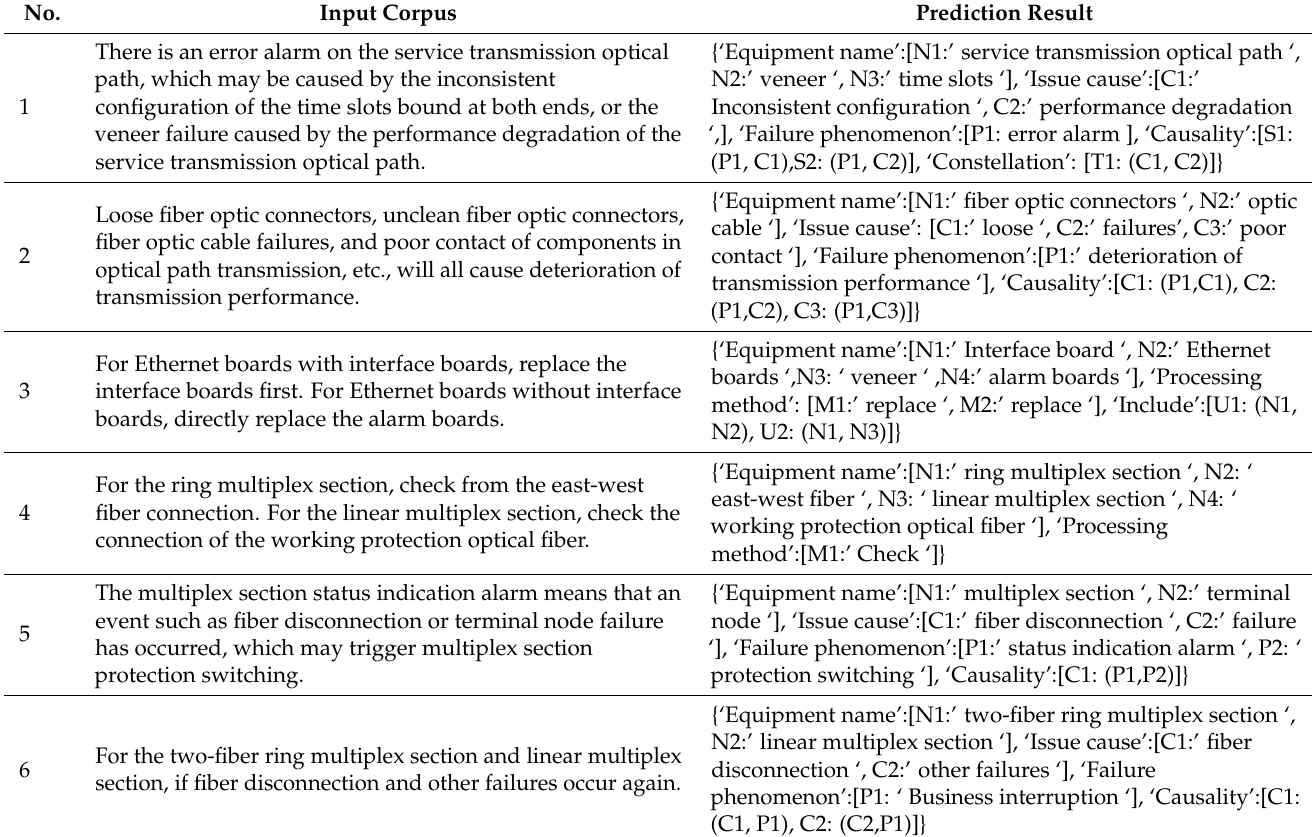
Table 7. Experimental Prediction Results of Joint Extraction